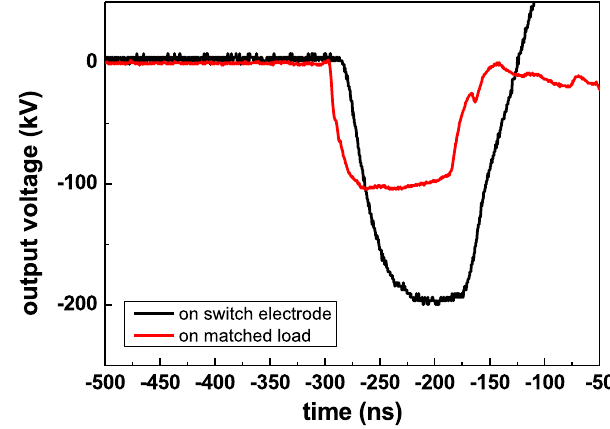
17. Parameter statistics for 50 LTD cavities. The hori- zontal axis represents the cavities number and the vertical axis represents the recorded parameters. The maximum currents are shown by the blue triangle; the rising times are shown by the green square, and the FWHMs are shown by red spots. The dashed lines around scatters represent the averaged